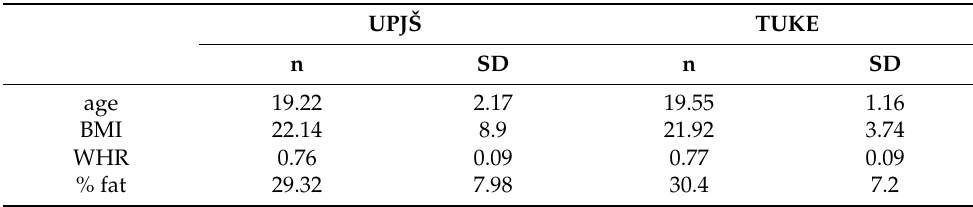
Table 1. Basic anthropometric indicators of respondents. UPJŠ TUKE n